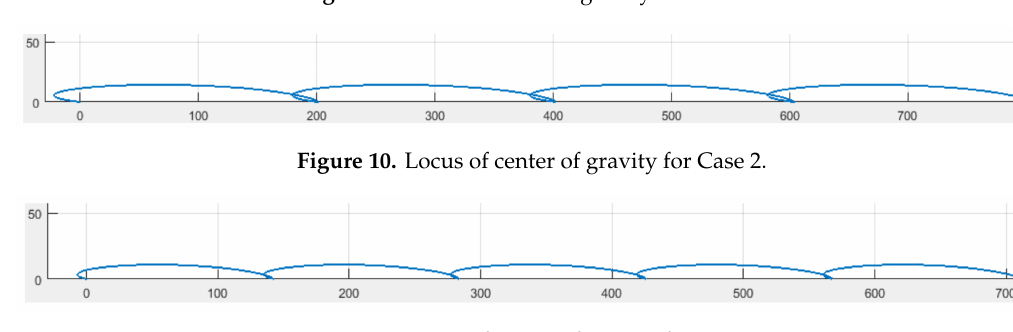
Figure 11. Locus of center of gravity for Case 3.